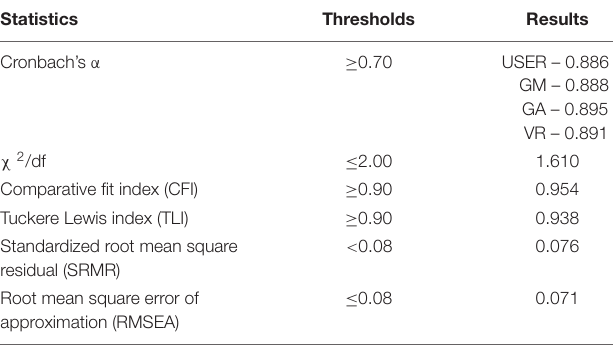
TABLE 2 | Internal reliability and goodness of fit for the